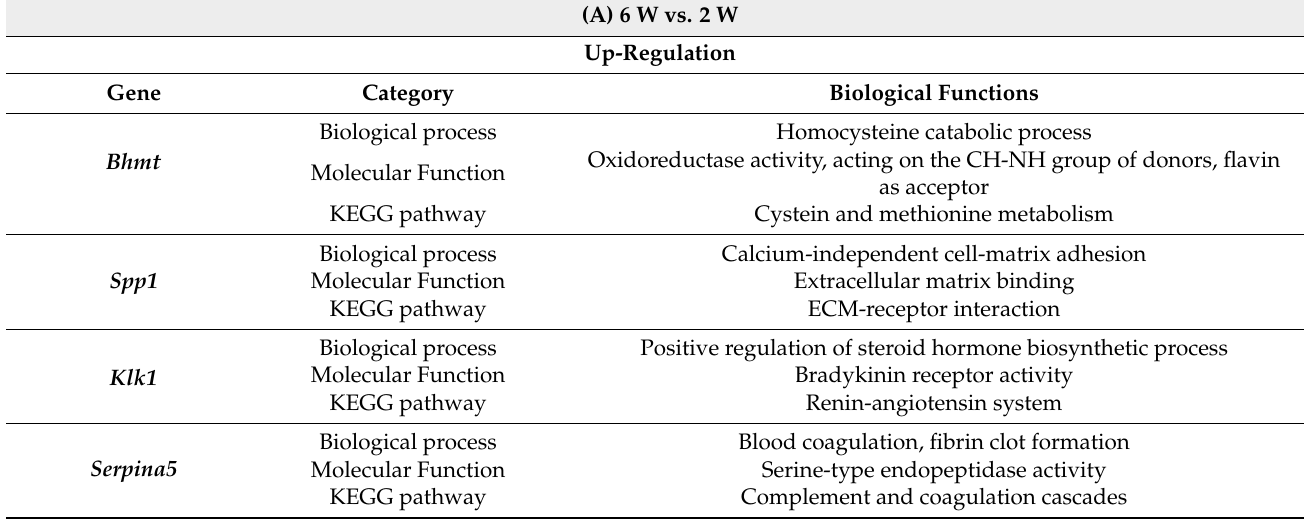
Table 3. Predicted protein interaction for up- and downregulated transcripts in the reproductively aged mouse ovary. Table 2. Fold changes among the groups were selected and their predictive interaction was analyzed using the STRING database. Redundant genes were indicated when they first appeared in the table. ( A ) 6 weeks (W) vs. 2 W, ( B ) 15 W vs. 2 W, ( C ) 20 W vs. 2 W, ( D ) 15 W vs. 6 W, ( E ) 20 W vs. 6 W, ( F ) 20 W vs. 15